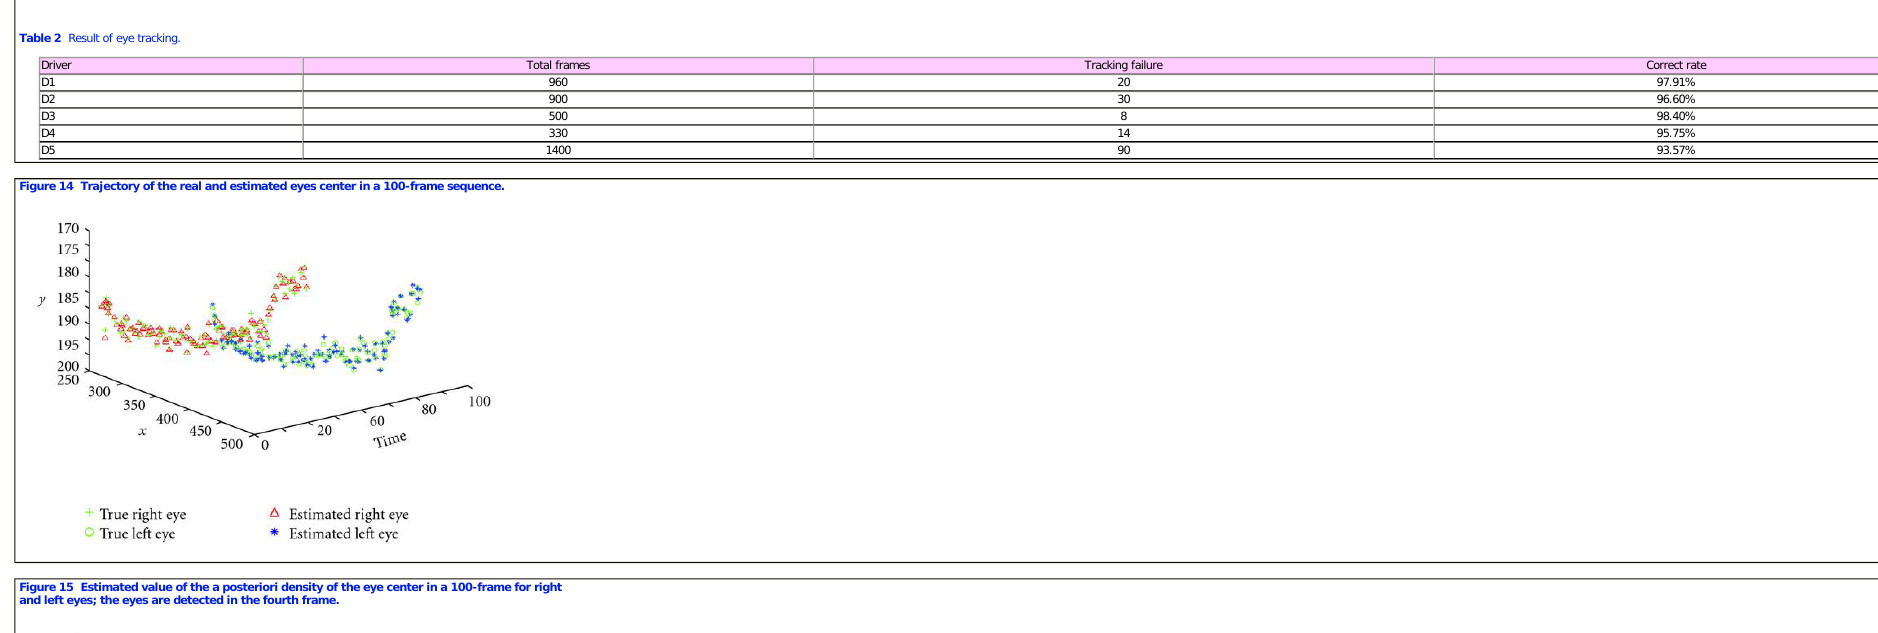
Figure 15 Estimated value of the a posteriori density of the eye center in a 100-frame for right and left eyes; the eyes are detected in the fourth